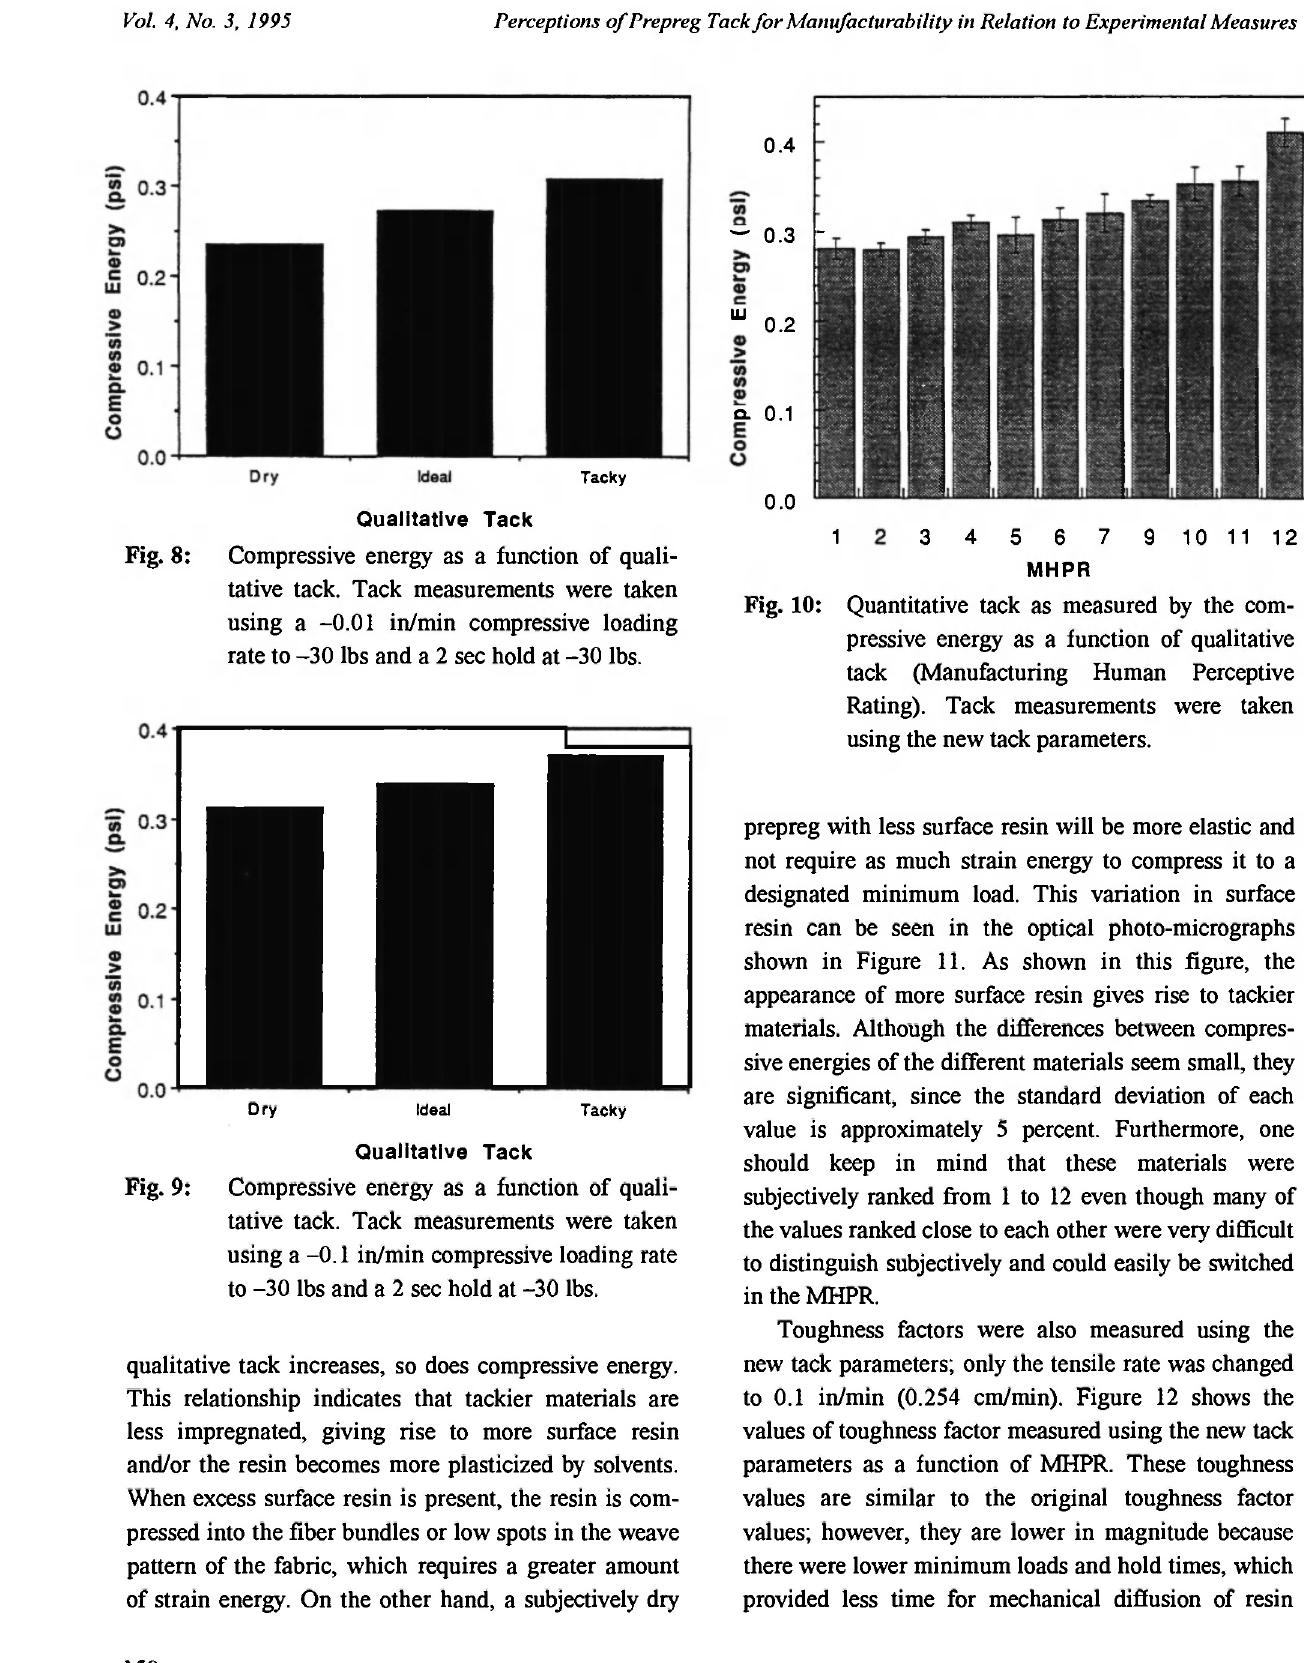
Dry Ideal Tacky Qualitative Tack Fig. 9: Compressive energy as a function of quali- tative tack. Tack measurements were taken using a -0.1 in/min compressive loading rate to -30 lbs and a 2 sec hold at -30 lbs.